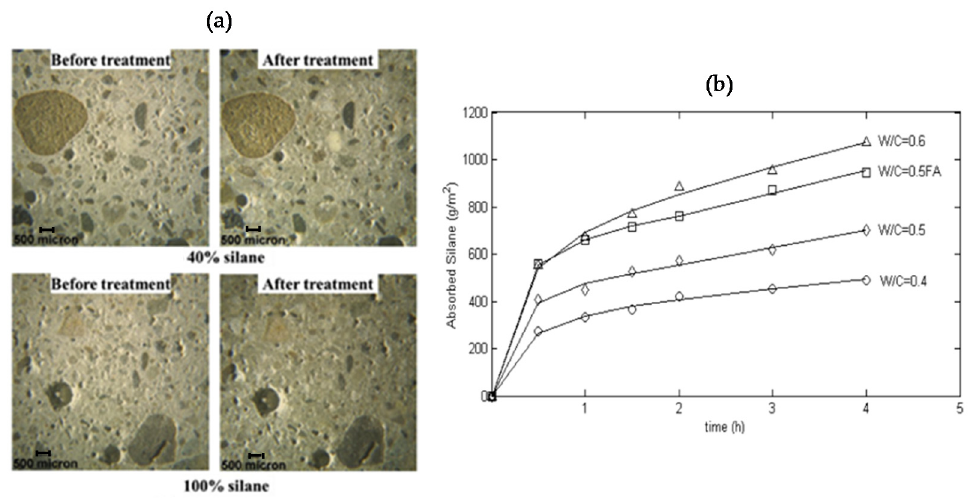
Figure 9. ( a ) Visual effect of a silane pore liner at different concentrations on a concrete specimen surface [49] and ( b ) absorbed silane as a function at different w/c (water/cement) ratios of concrete [36].